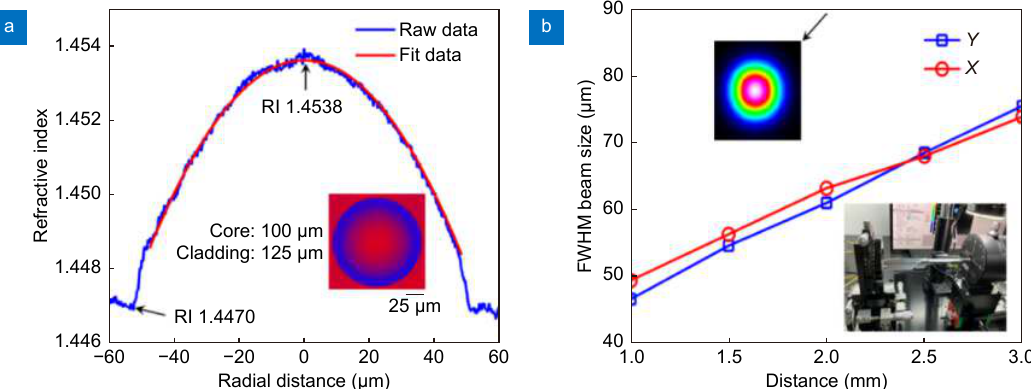
Fig. 2 | ( a ) Refractive index of the GRIN fiber. Inset: cross section of GRIN fiber captured by the refractive index profiler. ( b ) FWHM beam size at different position. Inset: beam profile at 2-mm position (left top); beam measurement setup (right